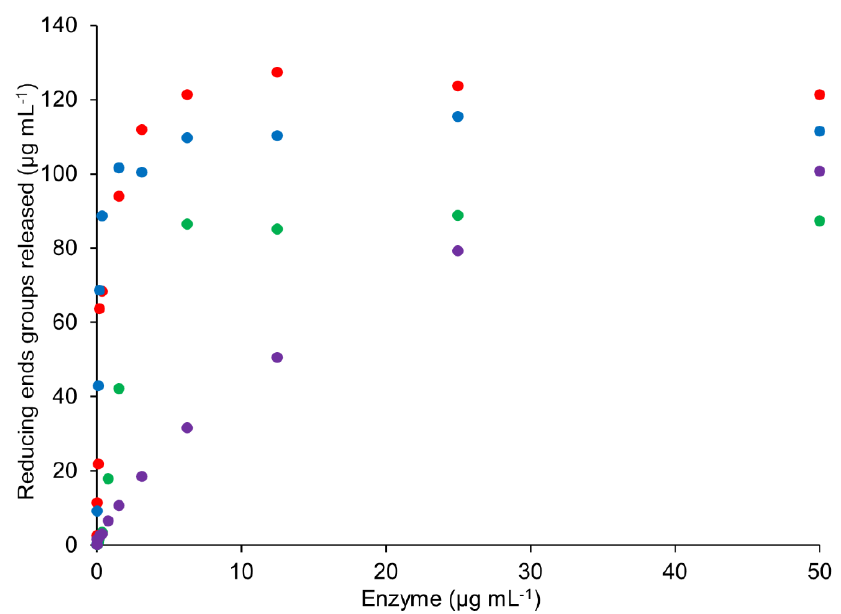
Figure 8. Reducing end groups released from 1 mg mL -1 AX by Mg ABF51 (red), Po ABF62 (blue), Hi ABF43_36a (green), and Tp ABF43_36b (purple) after 1 h incubation. Reaction conditions are displayed in Section 4.2.2, exp. # 3 and 4.